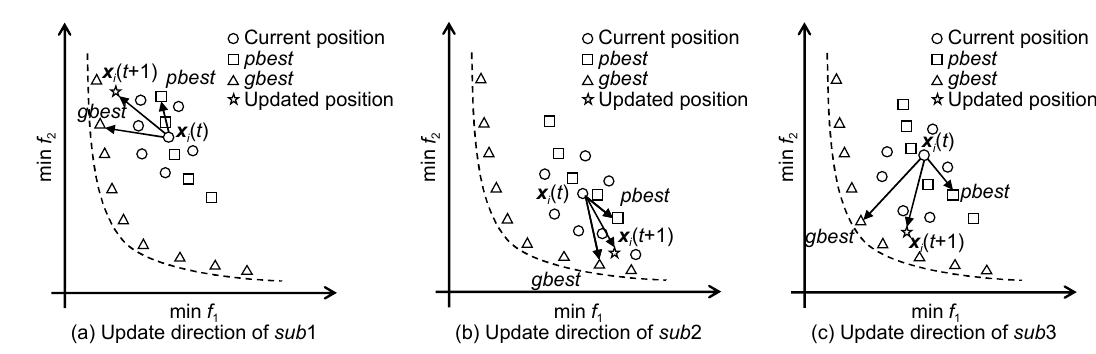
Fig. 6 Update directions of sub1, sub2, and